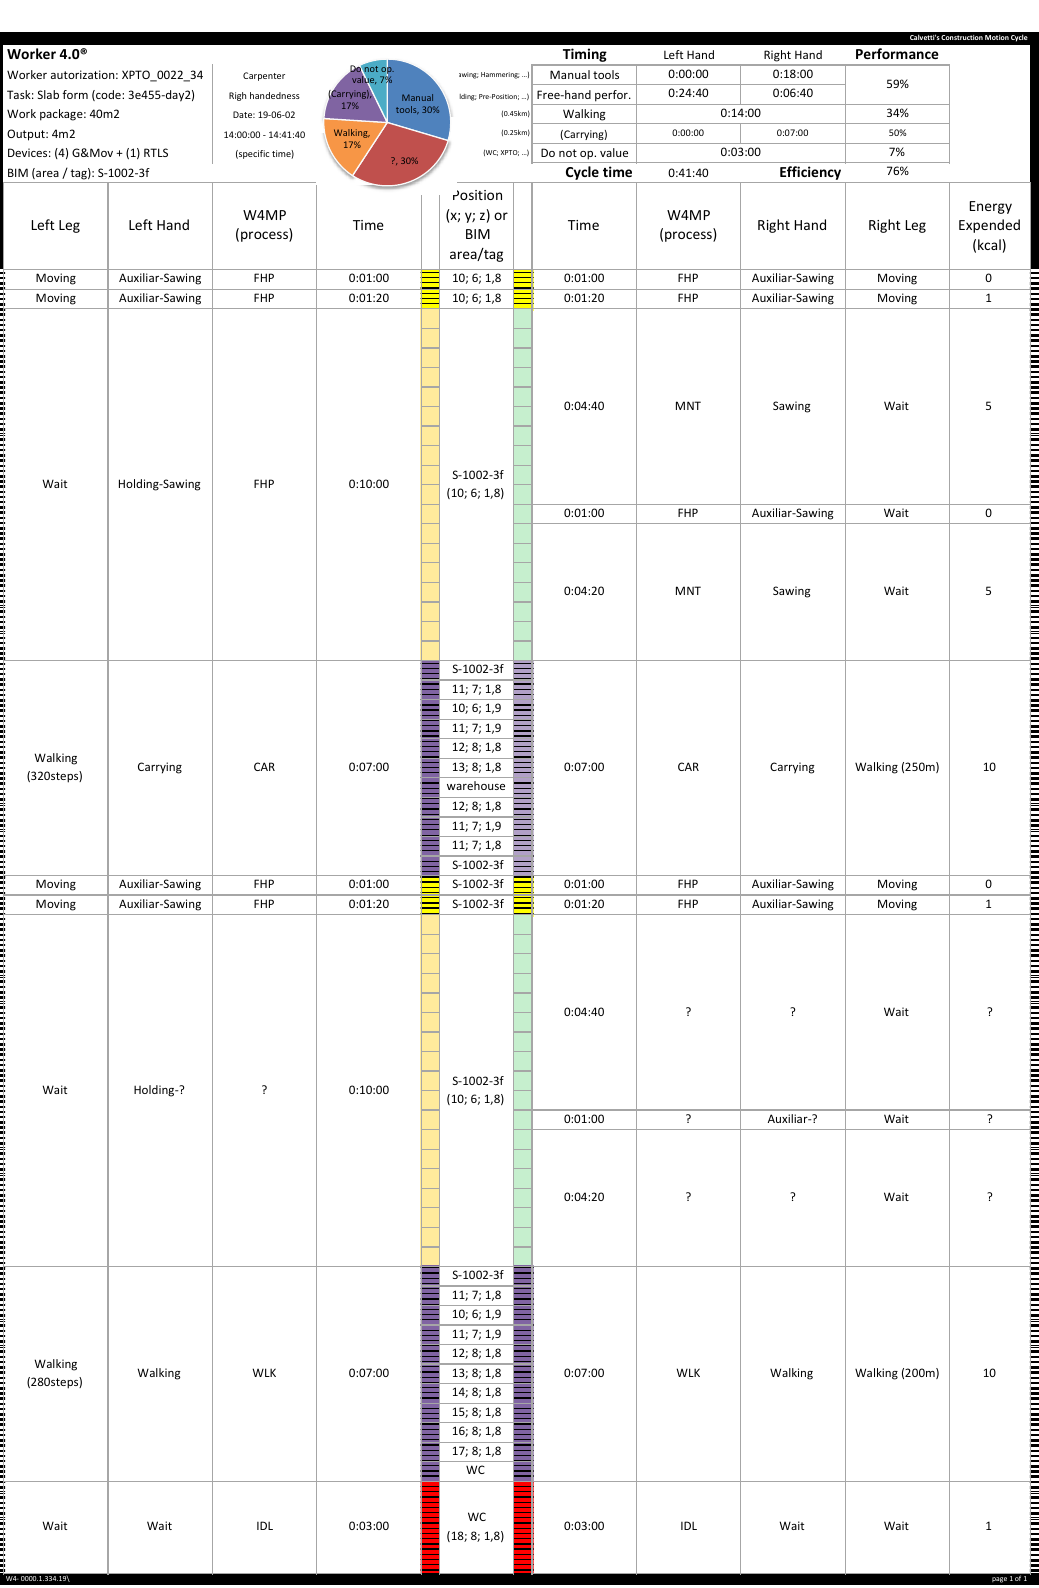
Figure 6. Worker 4.0: Two-handed, two-legged modeling chart.